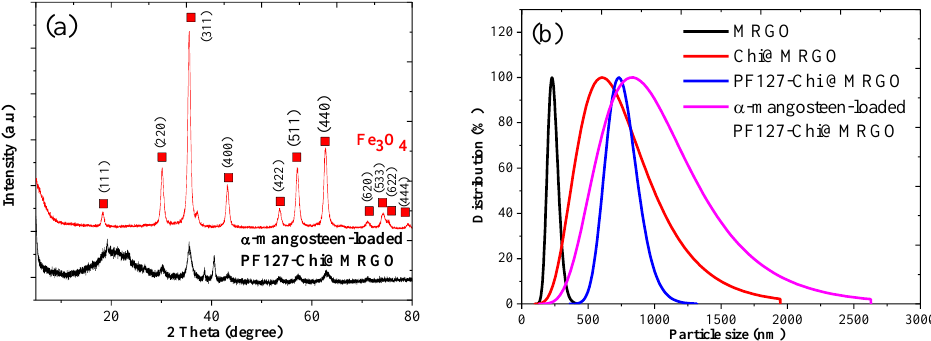
Figure 3. XRD spectra ( a ); particle size distribution ( b ) of nanocomposites.